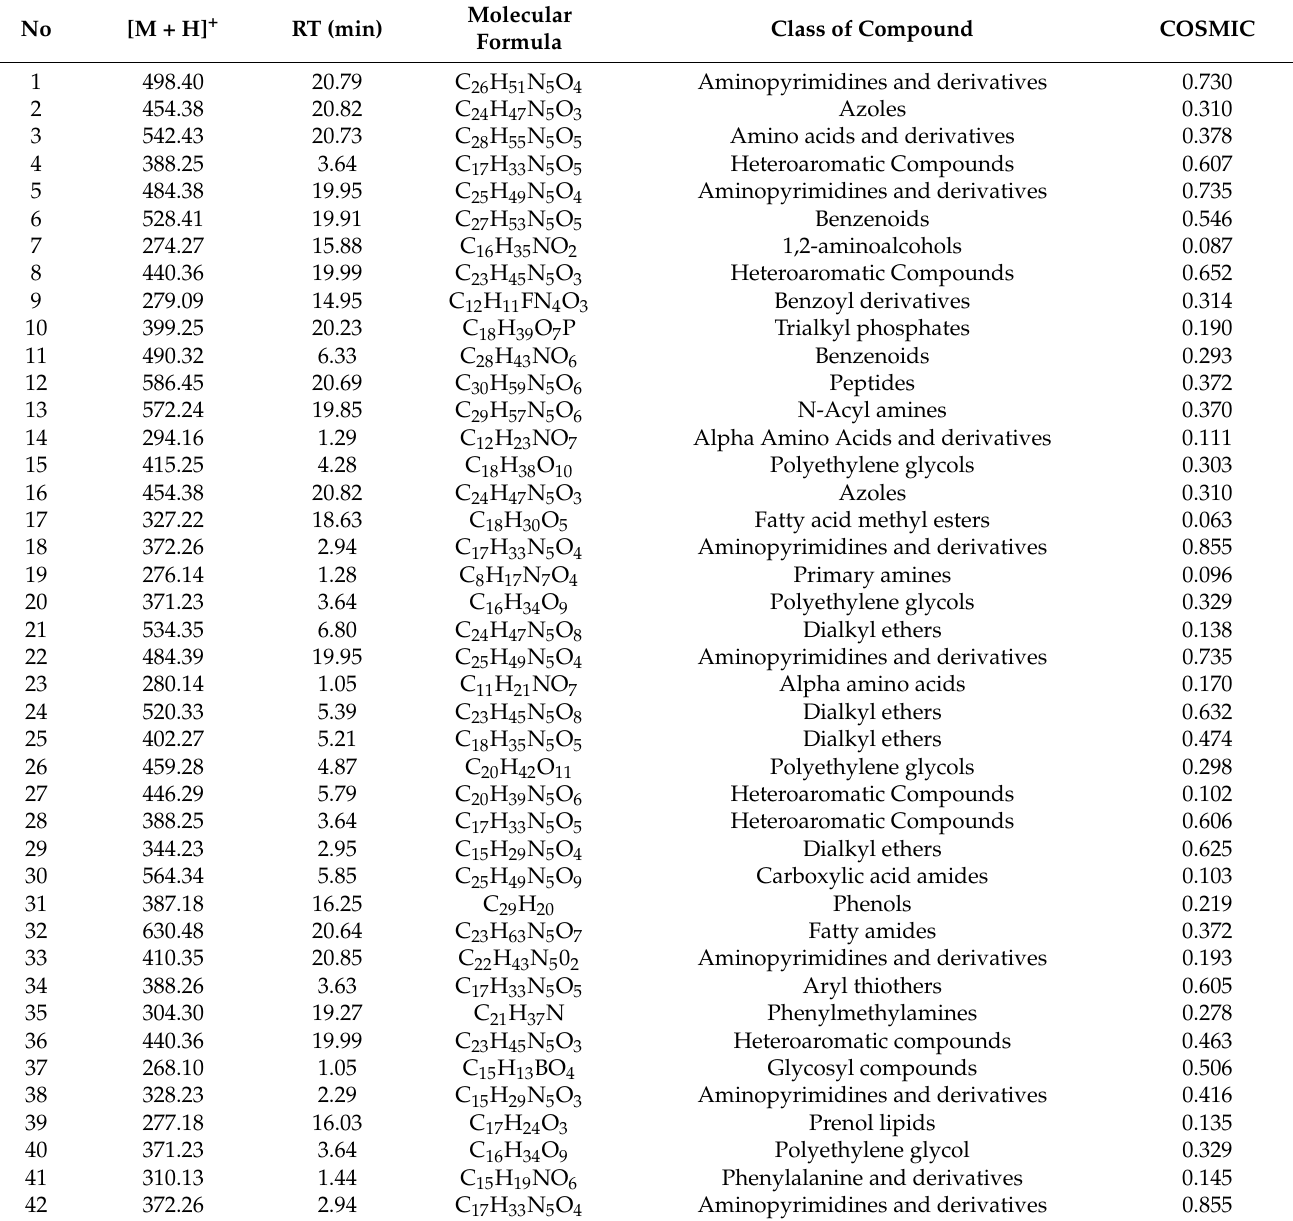
Table 5. List of characterized phytochemicals from SIRIUS